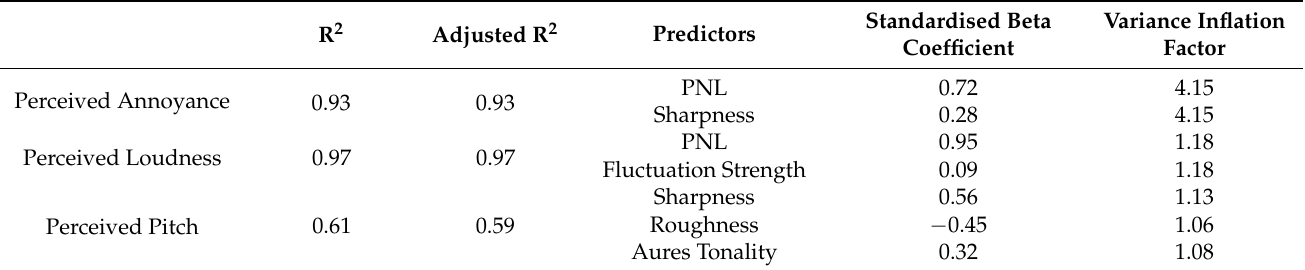
Table 8. Summary of multiple linear regression models to estimate perceived annoyance, loudness and